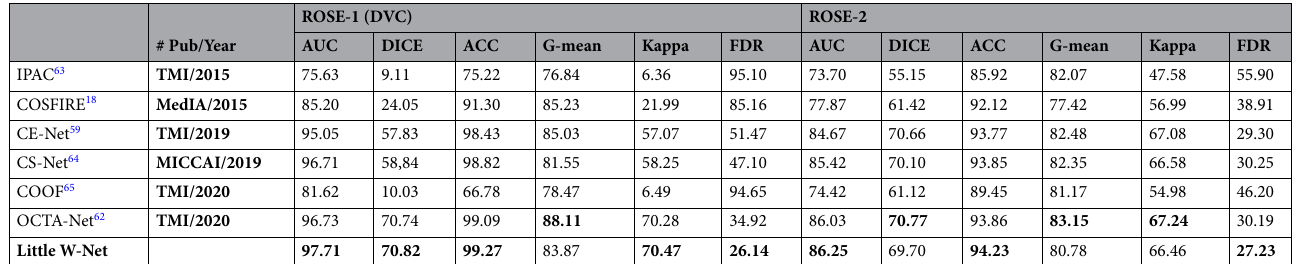
Table 7. Performance comparison for OCTA vessel segmentation on ROSE-1 (DVC) and ROSE-2. Best results are marked in